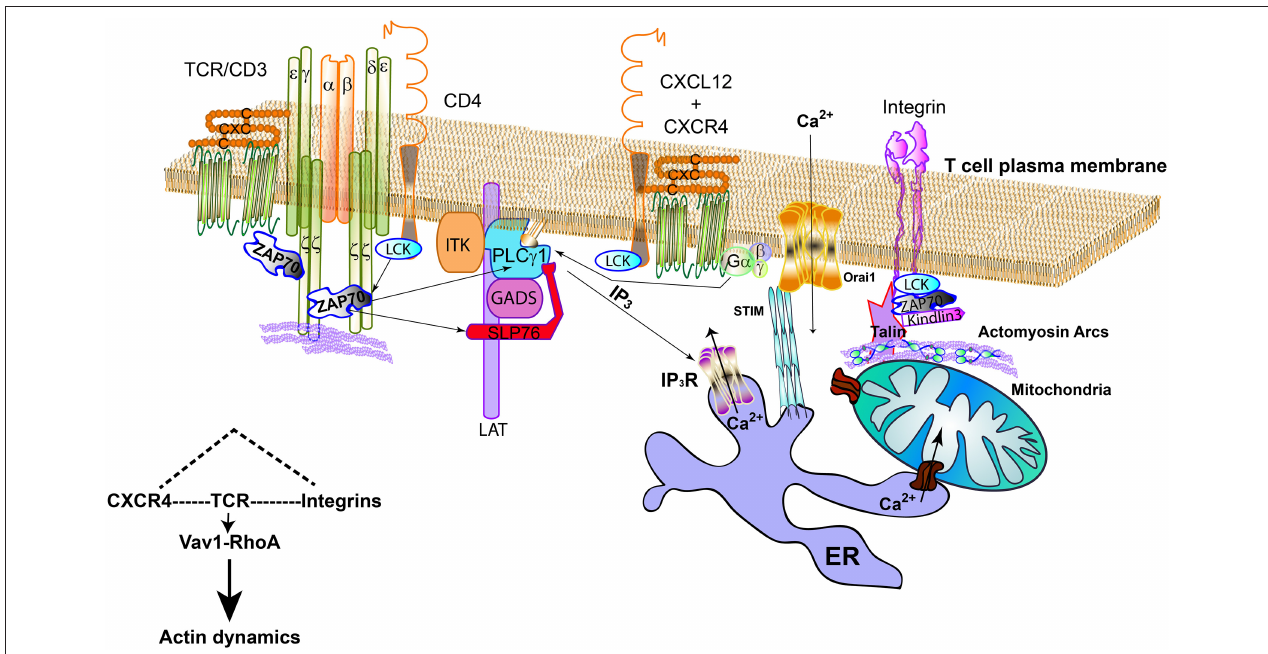
FIGURE 1 | TCR, LFA-1, and CXCR4 connecting signalosomes at the IS. The TCR activates by the binding to cognate antigen-MHC complexes; in CD4T cells, Lck bound to CD4 can help the phosphorylation of the cytoplasmic tails of CD3 subunits and ZAP70. CXCR4/CD4 complexes are found at the plasma membrane. Indeed, it can also interact with the TCR. ZAP70 is part of the CXCR4/TCR complex. CXCR4 may act on PLC γ 1, regardless binding to LAT, through the G proteins or ZAP70, producing inositol-3-phosphate (IP 3 ), which will activate the specific receptor (IP 3 R) at the endoplasmic reticulum (ER). This receptor allows Ca 2 + flowing from internal stores. The mitochondria can dock at the immune synapse and form specific bonds to the ER to facilitate the buffering of Ca 2 + . The activation of STIM at the ER promotes its clustering and the activation of CRAC channels (Orai1) at the plasma membrane, increasing the intracellular Ca 2 + by channel opening. Integrins cooperate with specific signaling elements such as Lck and ZAP70 to activate Kidling3 and Talin, allowing the binding to actin and actomyosin arcs. TCR, CXCR4, and integrins signaling pathways share the Vav1-RhoA